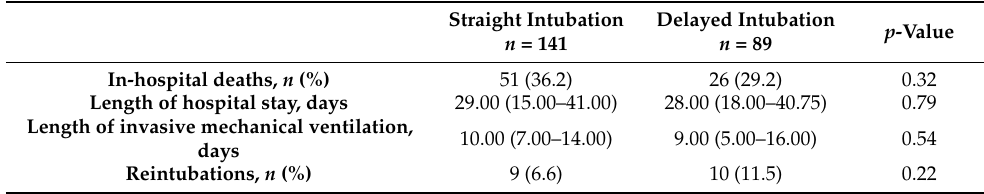
Table 3. Differences in major outcomes between patients who underwent “straight” intubation and delayed intubation (after NIV failure).